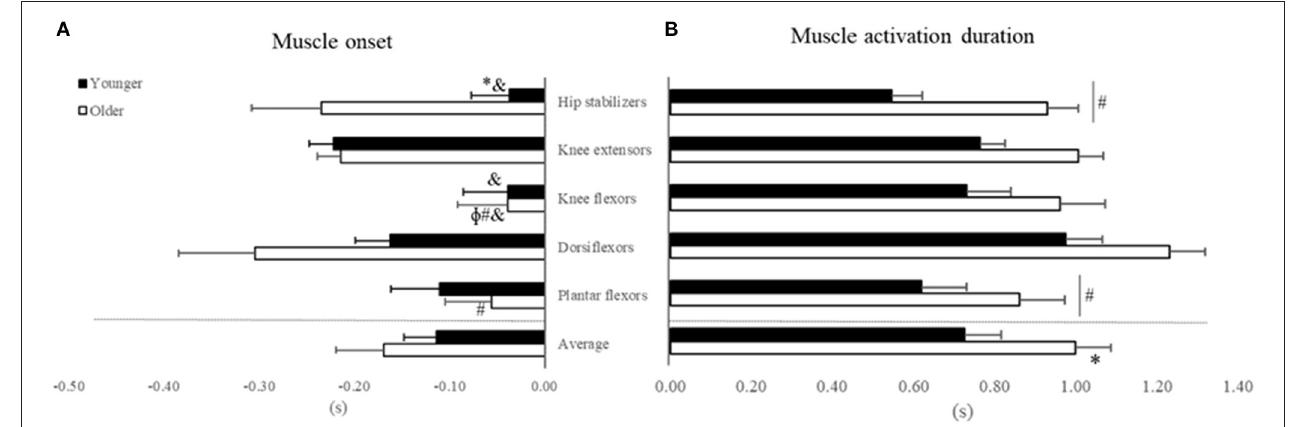
FIGURE 4 | Mean and Standard Error for (A) Muscle activation onset and (B) muscle activation duration in seconds (X-axis) relative to seat-off (Zero) for younger (filled bars) and older adults (open bars) in the initial-stage. *Age differences; # muscles that are different from dorsiflexors; & muscles that are different from knee extensors; φ muscles that are different from hip